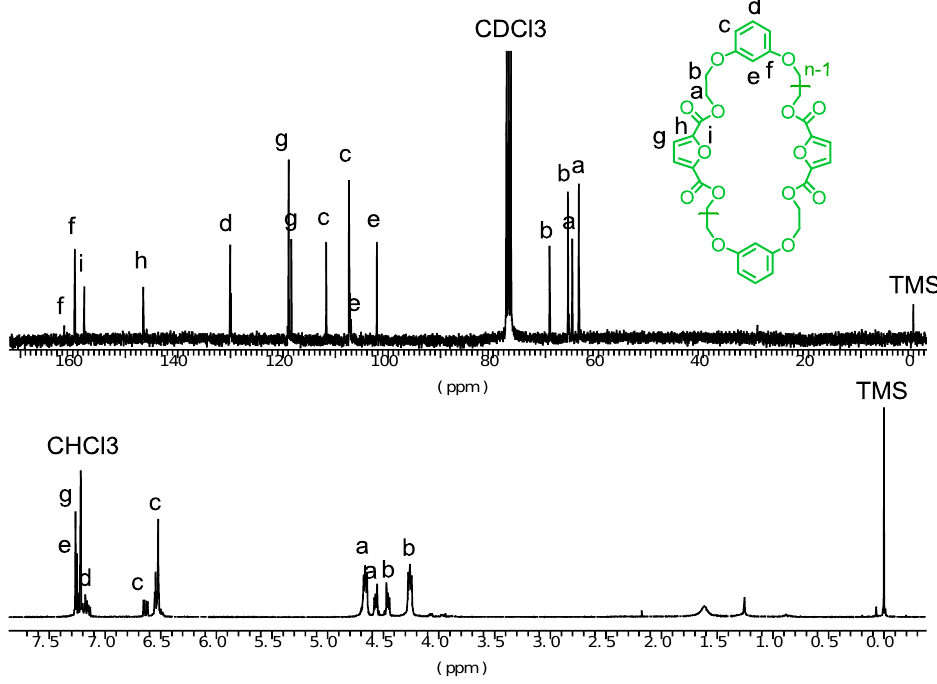
Figure 1. 1 H and 13 C NMR spectra of c (RF) n .